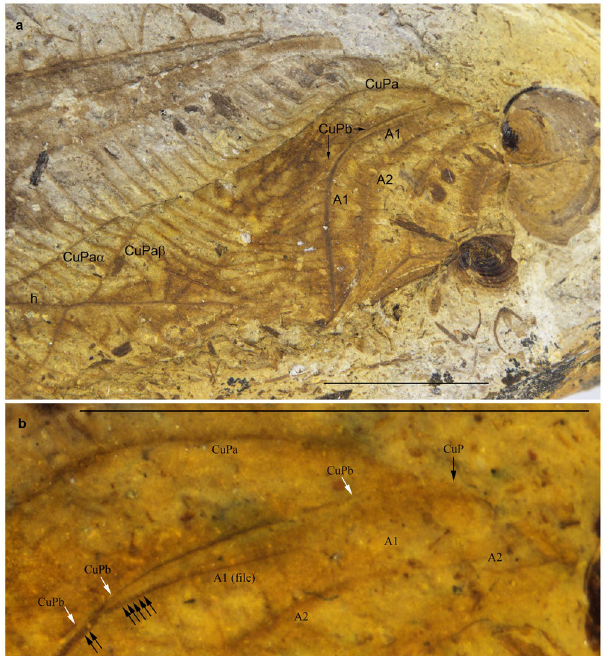
Figure 2. Wing venation interpretations. Liassophyllum caii Gu & Ren, 2012, holotype CNU-ORTNN2009008. ( a ) Wing base. ( b ) Magnification of bases of CuP and anal vein. Series of black arrows: teeth of the file; white arrows: course of CuPb meeting A1 (file) in one point. Scale bars = 5 mm (copyright Dong